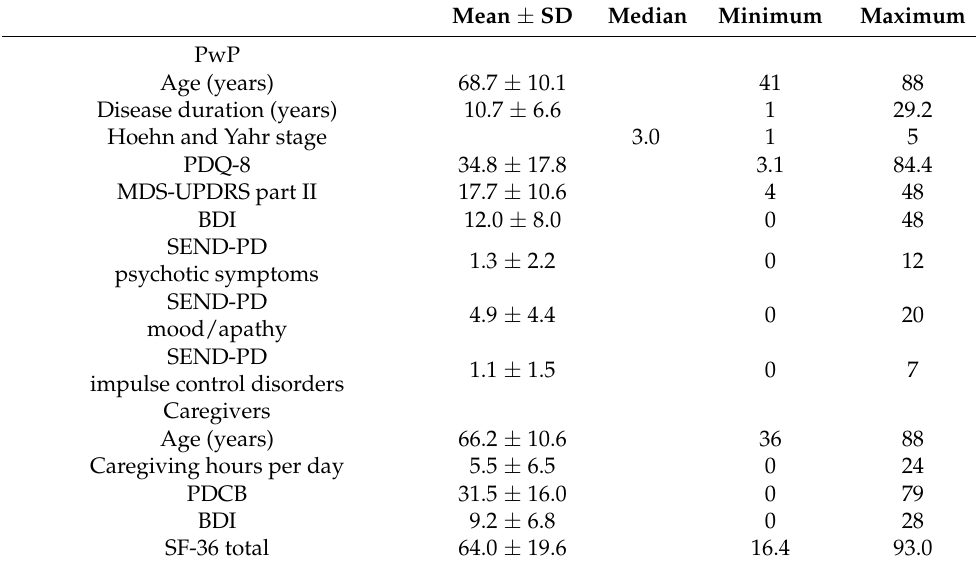
Table 1. PwP (n = 89; n = 34 females) and caregiver (n = 84; n = 54 females)